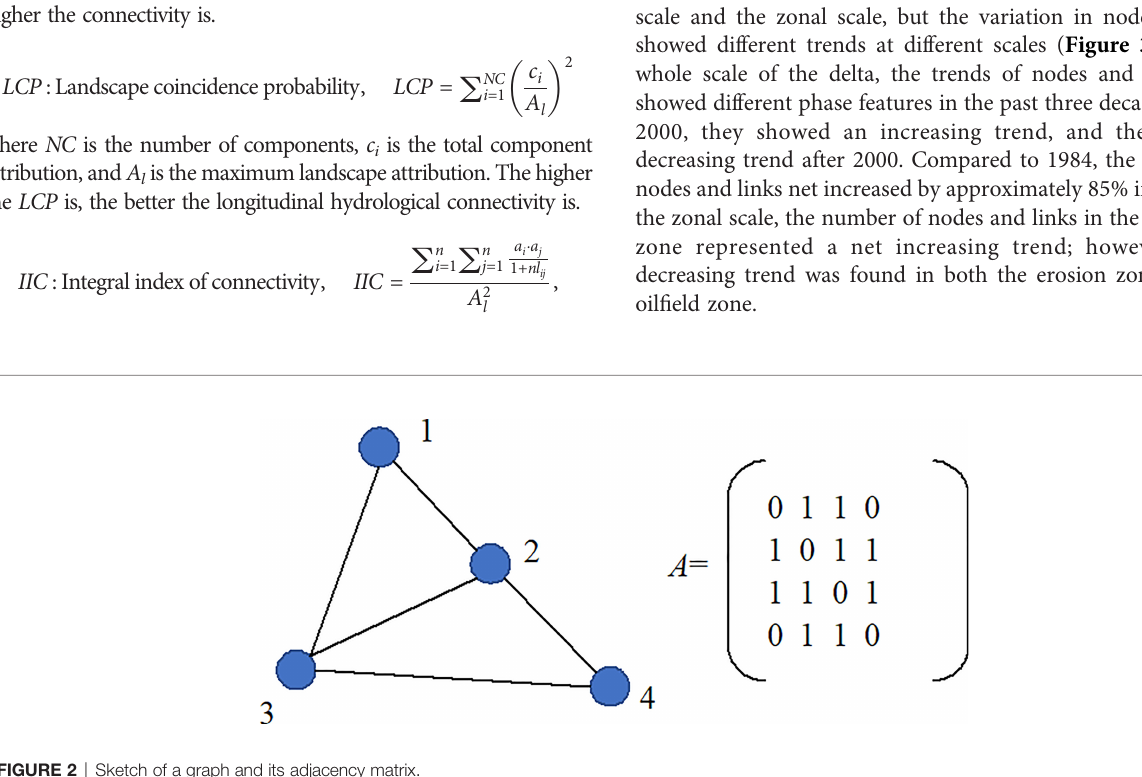
FIGURE 2 | Sketch of a graph and its adjacency